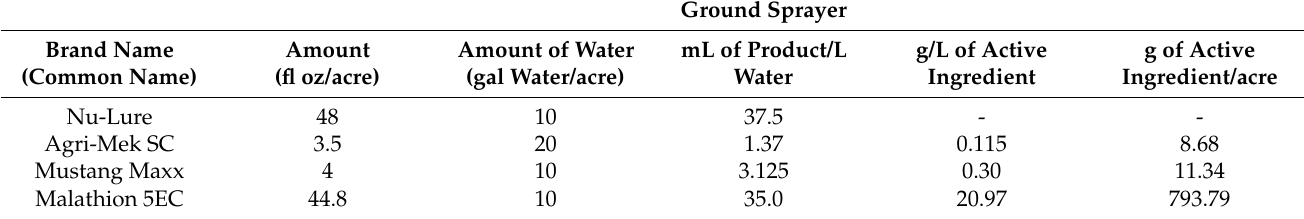
Table 2. The maximum label use rates for Agri-Mek SC, Mustang Maxx, and Malathion 5EC when applied directly to cucurbit crops to control various insect pests in Hawaii. The present study applied the insecticides (mixed with Nu-Lure Insect Bait) to roosting plants in the perimeter of cucurbit crop fields to control Zeugodacus cucurbitae